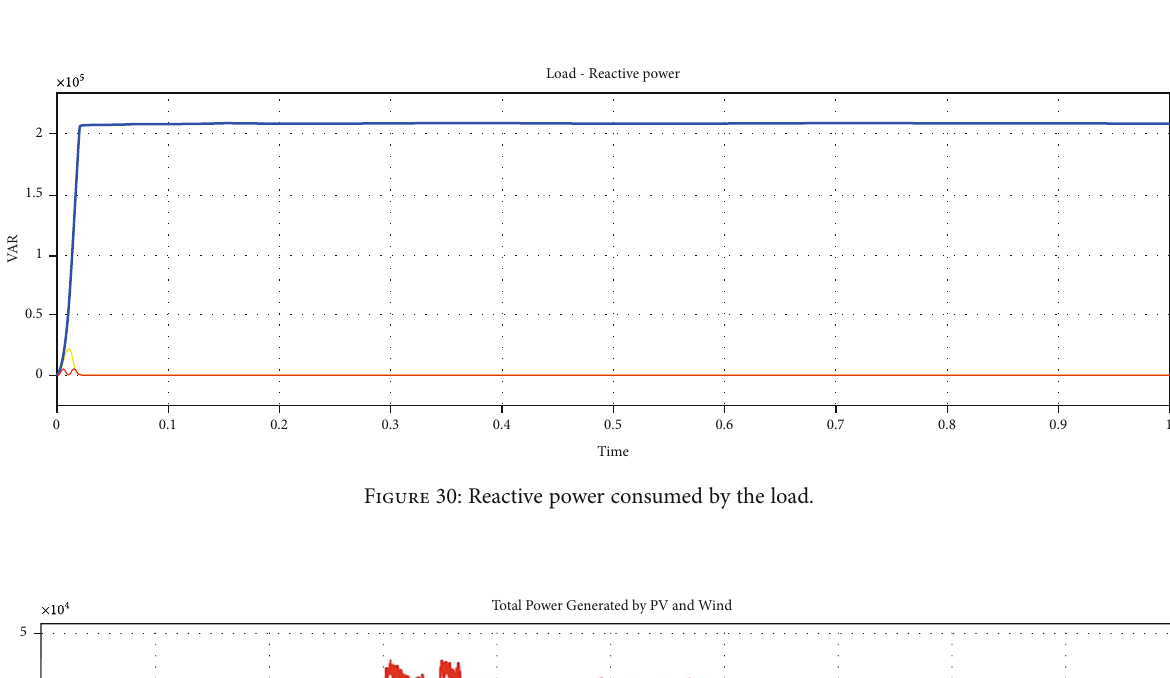
Figure 29: Real power consumed by the load.